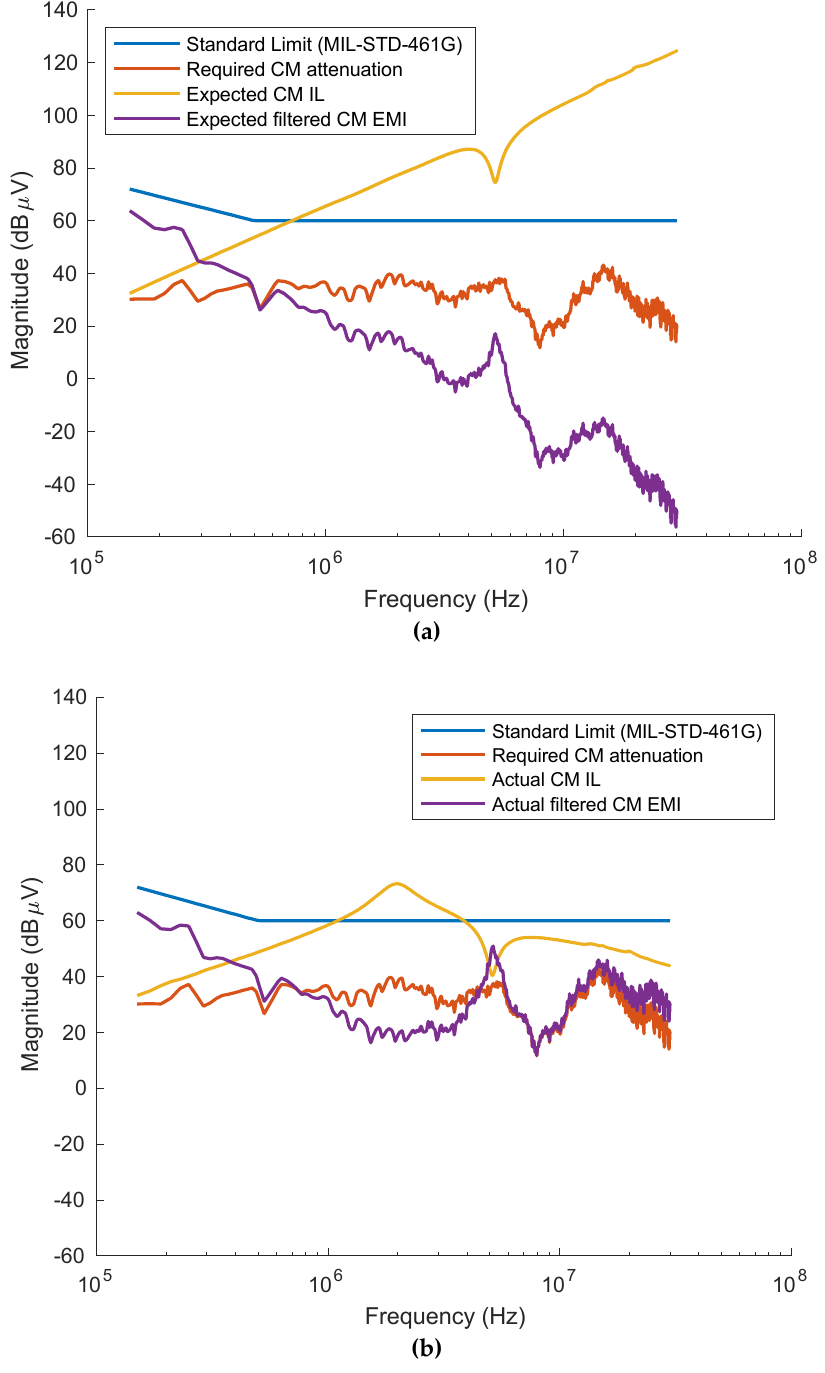
Figure 13. CM performance of the filter designed using the proposed approach: expected ( a ) and actual ( b ).